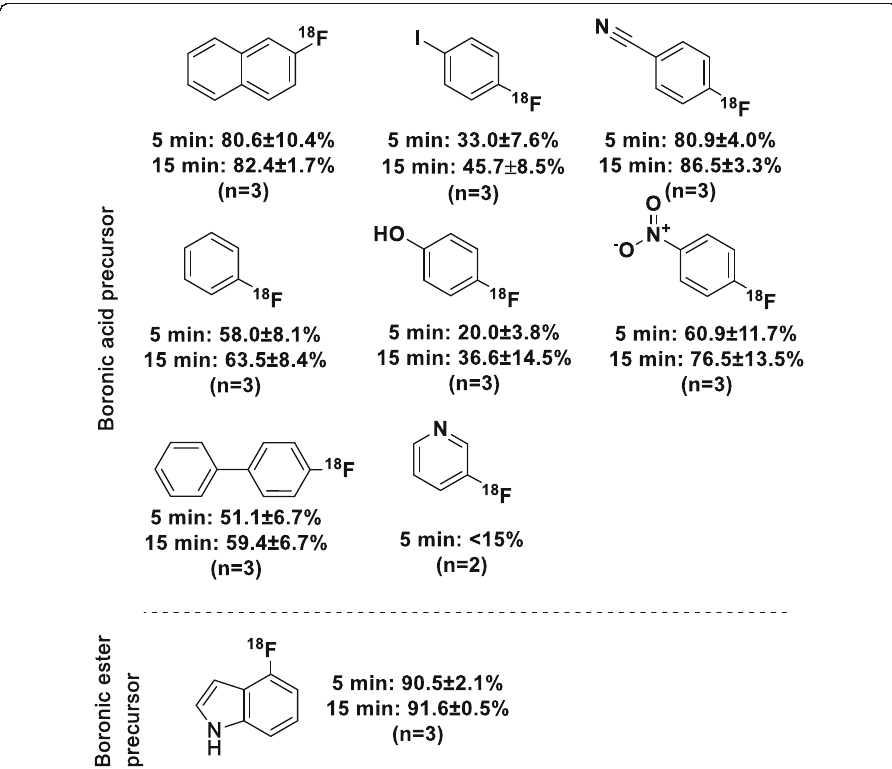
Fig. 1 Products with reaction times and RCY (based on the HPLC analyses of the reaction solution) values of copper-mediated 18 F-radiofluorination when using azeotropic drying free [ 18 F]fluoride activation method and aryl boronic acid or aryl boronic ester precursors